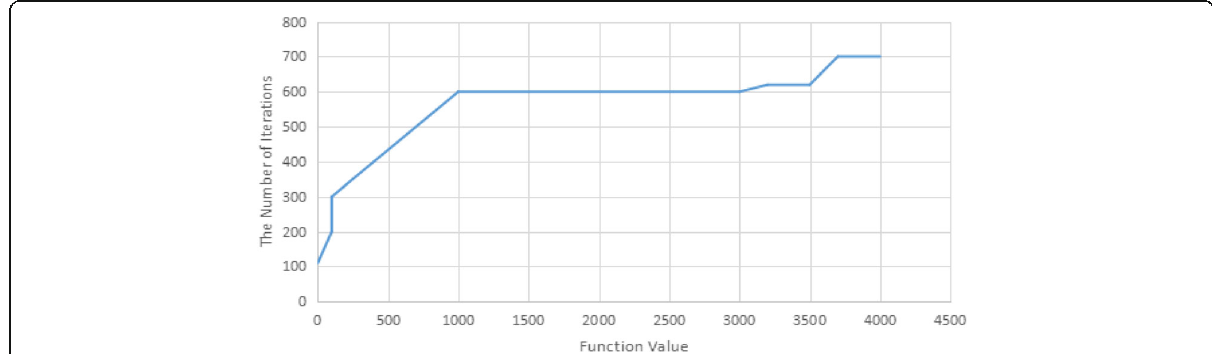
Fig. 1 The relationship between function value of projection objective and the numbers of iteration. Note: For this figure, the x axis represents the value of the numbers of iteration, while the y axis represents the value of projection objective. We could see that when we increase the numbers of iteration. The value of projective will also